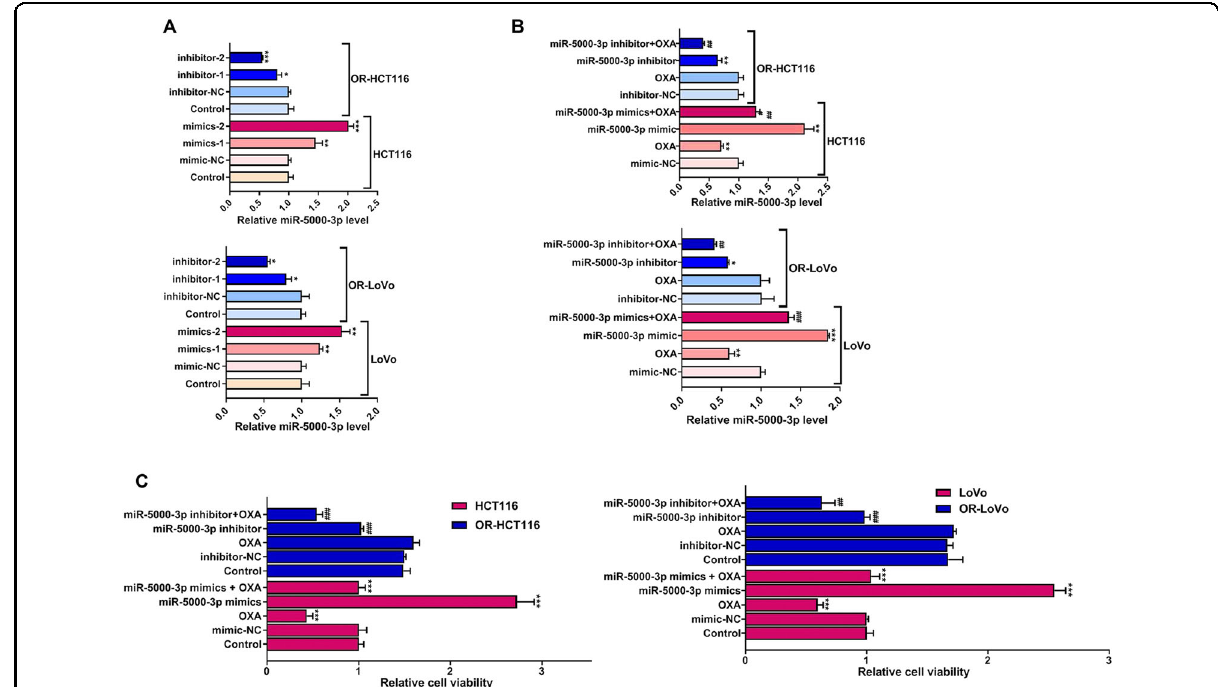
Fig. 2 The effect of the overexpression or knockdown of miR-5000-3p and treatment with or without OXA on cell survival of HCT116 and LoVo or OR-HCT116 and OR-LoVo cells in vitro. A miR-5000-3p expression after transfections with miR-5000-3p inhibitors or mimics in two OR- CRC cell lines or two CRC cell lines. B miR-5000-3p expression in HCT116 and LoVo or OR-HCT116 and OR-LoVo cells transfected with a miR-5000-3p mimics (40 nM), inhibitor (40 nM), or NC miRNA (40 nM) (mimics negative control (NC) or inhibitor NC) or treatment with OXA (45 µ M). miR-5000-3p fold increase which was calculated by the ratio miR-5000-3p/U6, being U6 snRNA constitutively expressed. C Relative cell survival fold changed of HCT116 and LoVo cells or OR-HCT116 and OR-LoVo cells determined by the MTT assay. * p < 0.05, ** p < 0.01, and *** p < 0.001; # p < 0.05, ## p < 0.01, and ### p <